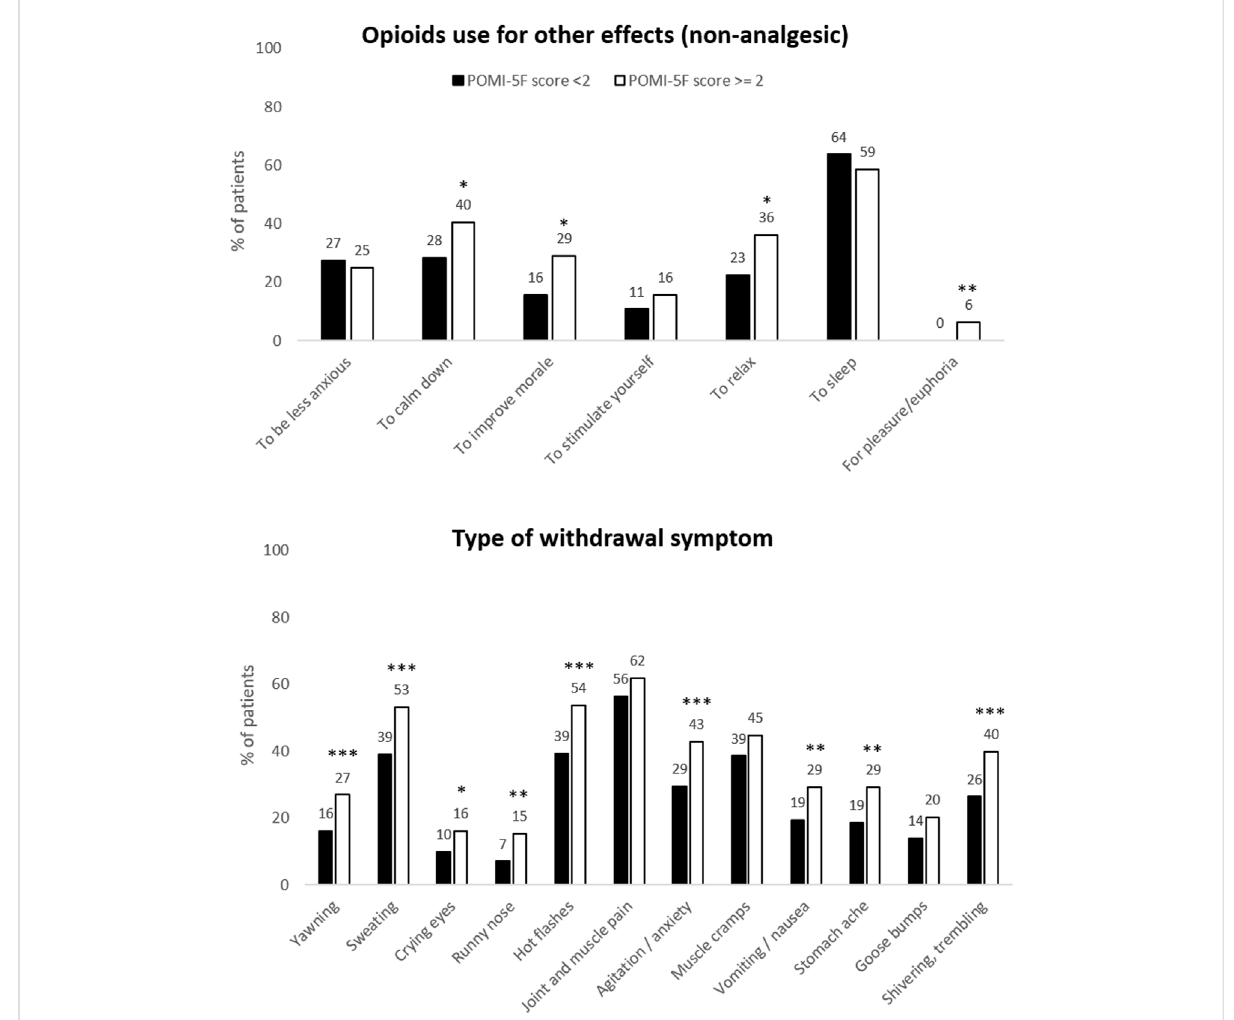
FIGURE 2 Type of opioid use for effects other than analgesia, and type of withdrawal symptoms. Data of all included patients ( n = 951) are presented as a bar chart with associated percentages. Misusers (POMI-5F score ≥ 2) are in white bars and non-misusers (POMI-5F score < 2) are in black bars. * p < 0.05; ** p < 0.01 and *** p <